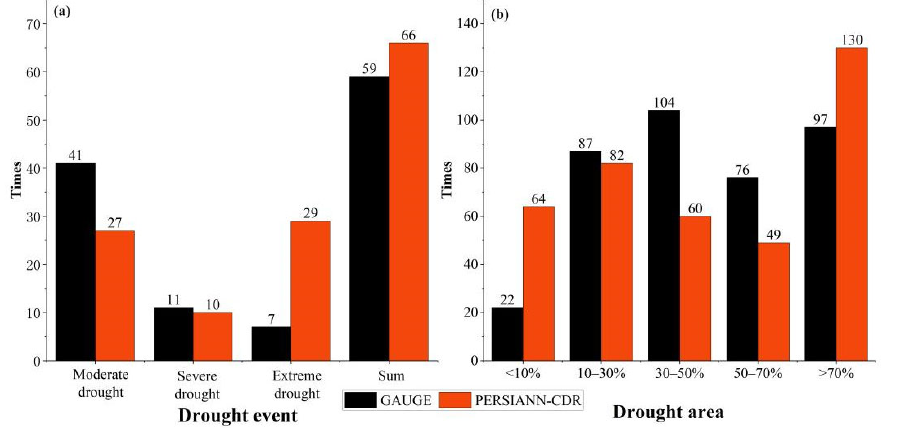
Figure 11. Comparison between PERSIANN-CDR and gauges observation of occurrence frequency of droughts at ( a ) different drought levels and ( b ) different drought